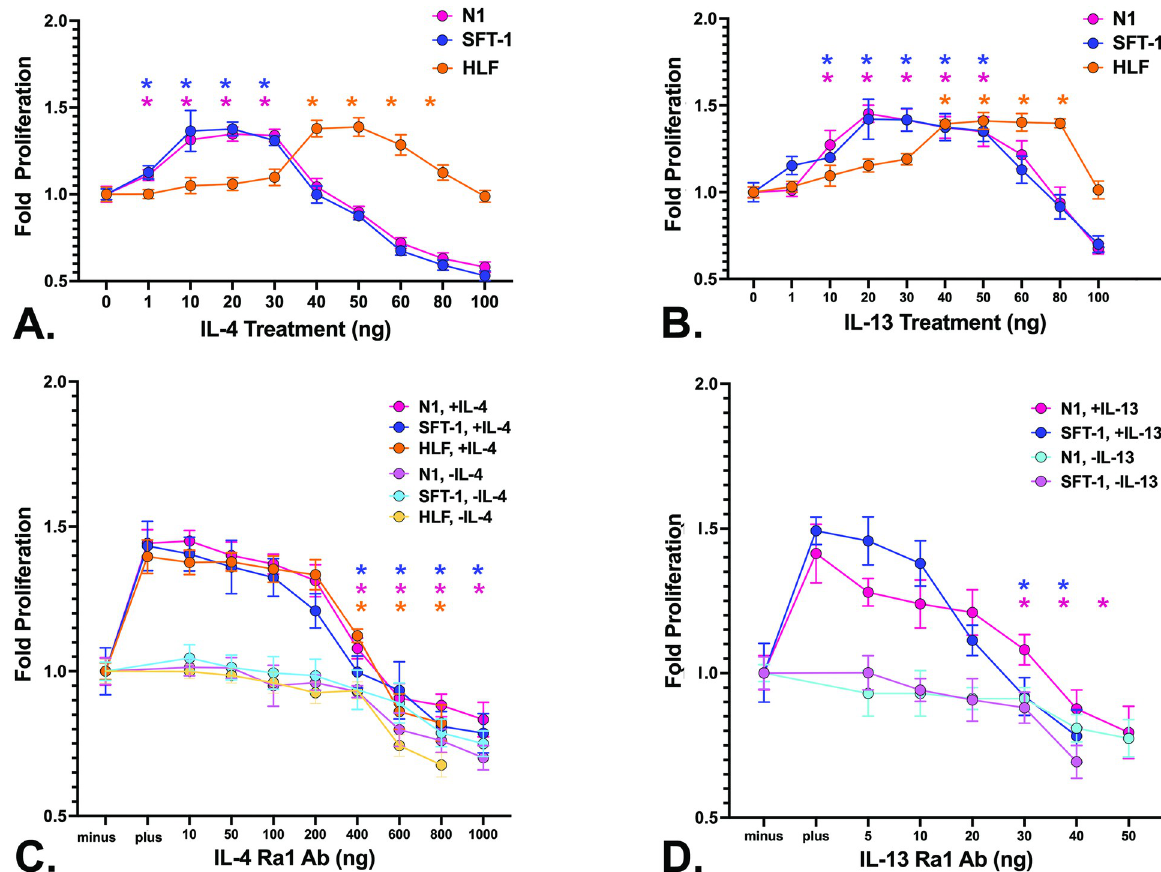
Fig 2. Low doses of IL-4 and IL-13 enhance cellular proliferation. A, B. N1 and SFT1 prostate fibroblasts and HLF primary lung fibroblasts were cultured in serum-free defined media supplemented with vehicle or increasing doses (1–100 ng) of human recombinant IL-4 ( A ) or IL-13 ( B ) for 24 hours. Proliferation was assessed by WST assay. Average cell numbers and standard deviations were calculated. Both IL-4 ( A ) and IL-13 ( B ) maximally stimulated the proliferation of N-1 and SFT-1 cells at a concentration of 20 ng/ml and of HLF cells at 40 ng/ml. These concentrations of IL-4 and IL-13, respectively, were therefore chosen for subsequent studies using N1, SFT-1, or HLF cells. Statistically (p < .05) increased proliferation levels compared to control are indicated as � in corresponding colors. C, D. N1 and SFT1 prostate fibroblasts and HLF primary lung fibroblasts were cultured in serum-free defined media, pre-treated for 2 hr with increasing doses of anti-IL-4R α (10–1000 ng) ( C ) or IL-13R α 1 (5–50 ng) ( D ) antibodies, then cultured for 24 hr in the presence of 20 (N1, SFT-1 cells) or 40 (HLF cells) ng/ml IL-4 or IL-13, respectively. IL-4 failure to induce proliferation above basal levels (1-fold proliferation) was observed using 400 ng anti-IL-4R αα ( C ), whereas IL- 13 failure to induce proliferation above basal levels (1-fold proliferation) was observed using 40 ng anti-IL-13R α 1 ( D ). These concentrations of anti-IL-4R α and anti-IL-13R α 1, respectively, were therefore chosen for subsequent studies using N1, SFT-1, or HLF cells (S2 Fig). Statistically (p < .05) decreased proliferation levels compared to control are indicated as � in corresponding colors. than IL-13, as 10X higher IL-4R α than IL-13R α 1 antibody levels were required to repress this response. Alternatively, this result may be due to differences in ligand/receptor affinities.